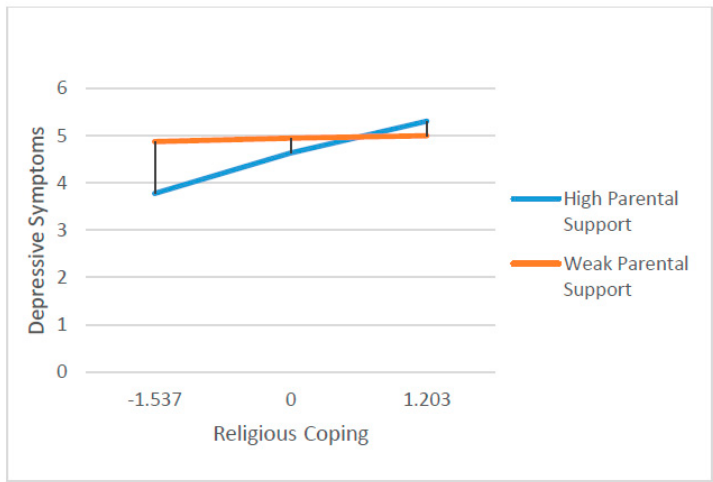
Figure 1. Predicted Depressive Symptoms by Weak Parental Support and Religious Coping, Interracial Relationships.